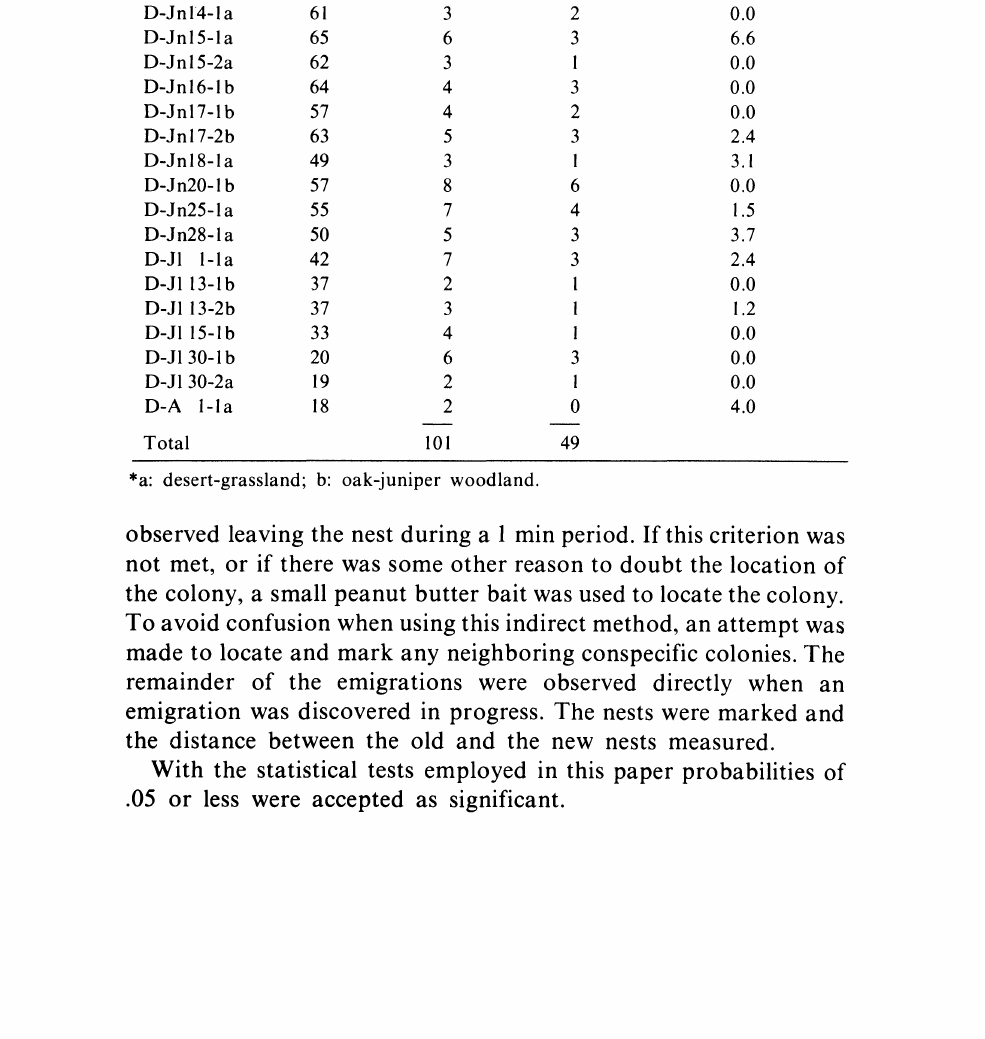
Table 2. Emigration characteristics of P. desertorum. Distance Between First Days Number of Returns to a and Last Observed Colony Observed Emigrations Former Nest Nests